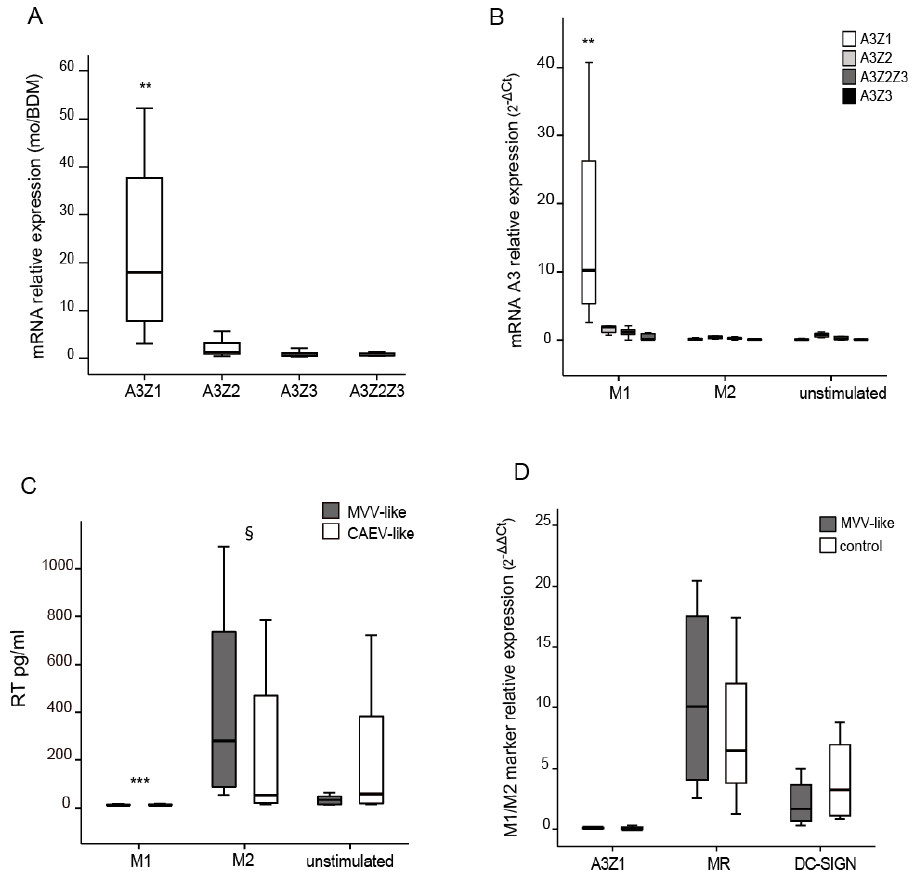
Figure 1. Relative Apolipoprotein B editing enzyme catalytic polypeptide-like 3 (APOBEC3) expression in Blood Derived Macrophages (BDM) and Small Ruminant Lentiviruses (SRLVs) replication. ( A ) A3Z1, A3Z2, A3Z3 and A3Z2-Z3 relative expression measured by quantitative RT-PCR in blood monocytes (mo) versus blood derived macrophages, BDM (2 − ∆∆ C t ); ( B ) A3Z1, A3Z2, A3Z3 and A3Z2-Z3 relative expression in BDM stimulated with interferon gamma, IFN- γ (M1), interleukin 4, IL-4 (M2) or control (unstimulated) for 6 days (2 − ∆ C t × 100); ( C ) Retrotranscriptase (RT) activity (pg/mL) measured in clarified supernatants of stimulated BDM infected with 0.1 multiplicity of infection (MOI) of SRLVs strains from Maedi Visna virus (MVV)-like (grey bars) and Caprine Arthritis Encephalitis virus (CAEV)-like (empty bars) for 7 days; ( D ) A3Z1, MR, DC-SIGN relative expression in unstimulated BDM infected with SRLVs from MVV-like (0.1 MOI). Values are the median ( ± interquartile range) of at least three independent experiments, significantly lower (** p < 0.01; *** p < 0.001); significantly higher ( § p < 0.05) (paired Mann-Whitney U Test). (MR: Mannose Receptor. DC-SIGN: Specific Intercellular adhesion molecule-3-Grabbing Non-integrin).